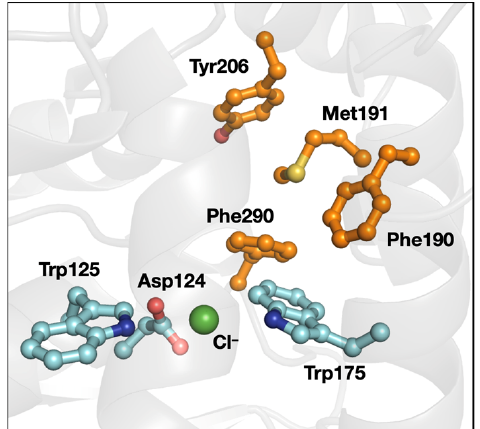
Figure 8. Structure of X. autotrophicus haloalkane dehalogenase (PDB ID 1B6G [55]). The 3-bridge cluster is highlighted in orange and the catalytic aspartate (Asp) and halide-stabilizing Trp are in cyan. Red corresponds to oxygen, yellow to sulfur, blue to nitrogen, and green to chloride. The image was generated using PyMOL.